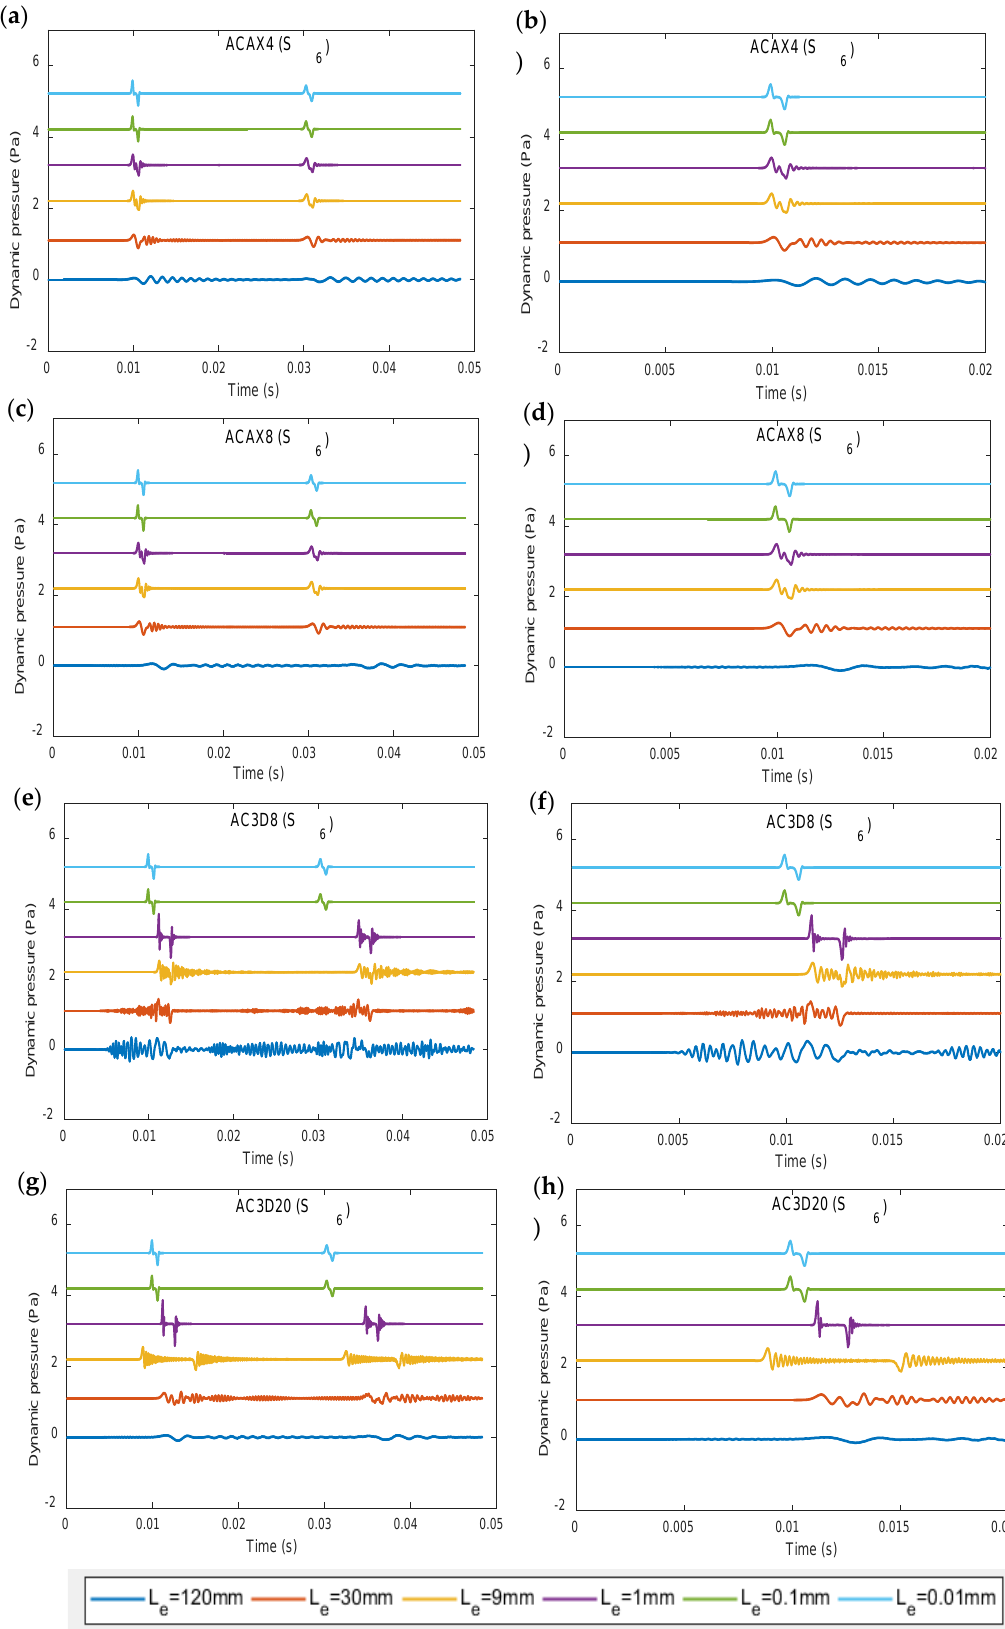
Figure 13. ( a , c , e , g ) Stacked Plots of pressure vs. time predicted at s 6 using ACAX4, ACAX8, AC3D8 and AC3D20 elements respectively. ( b , d , f , h ) Magnified view of pressure vs. time response predicted using ACAX4, ACAX8, AC3D8 and AC3D20 elements respectively (All plots start with zero amplitude).